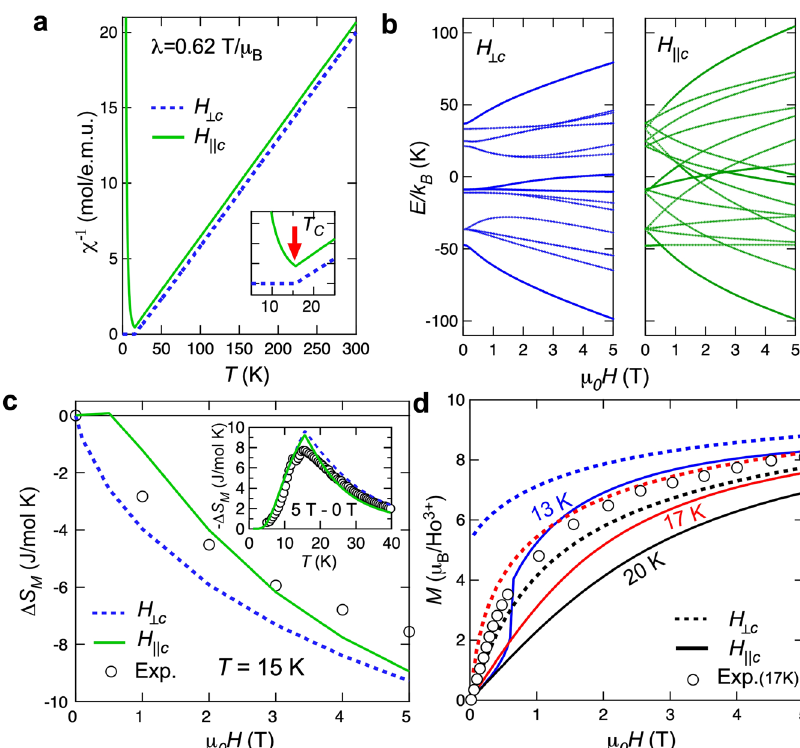
Fig. 4 Results of mean- fi eld calculation with the experimentally determined CEF parameters in HoB 2 . a Temperature dependence of the inverse magnetic susceptibility along the principal directions, ( b ) Zeemann splittings of energy levels at 20 K, c magnetic entropy changes ( Δ S M ) at 15 K and ( d ) magnetizations below 20 K in magnetic fi elds perpendicular and parallel to the hexagonal c -axis. Open circle symbols in c , and d the experimental data at 17 K taken from ref. 4 . The inset in ( c ) shows the temperature dependence of Δ S M when the magnetic fi eld is change from 0 to 5